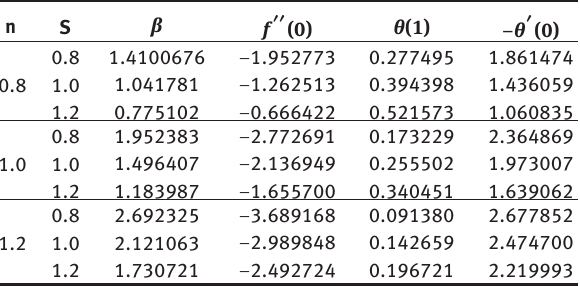
Table 4: Values for β , f (cid:2)(cid:2) (0) , θ (1) and − θ